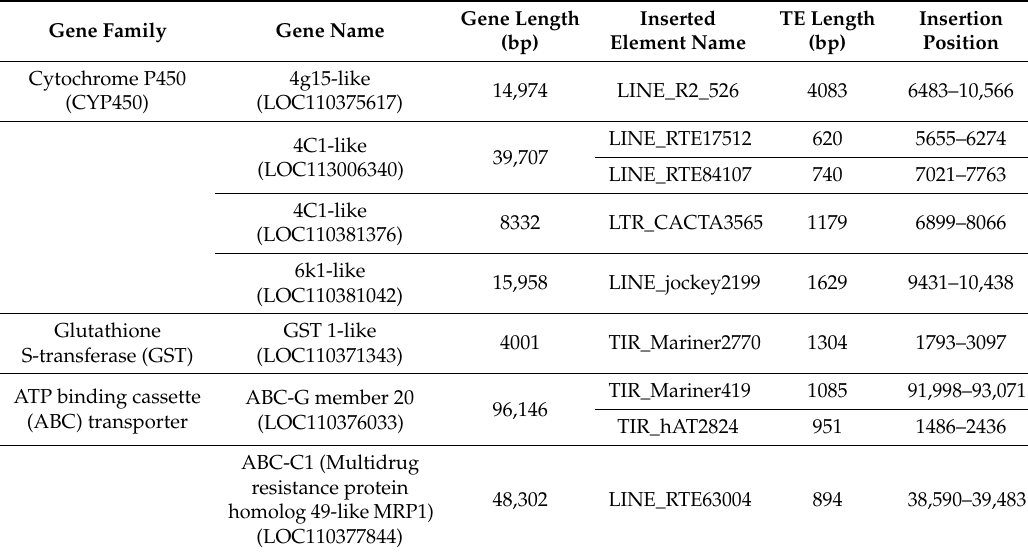
Table 3. TE insertions in genes encoding for detoxifying enzymes in H. armigera.